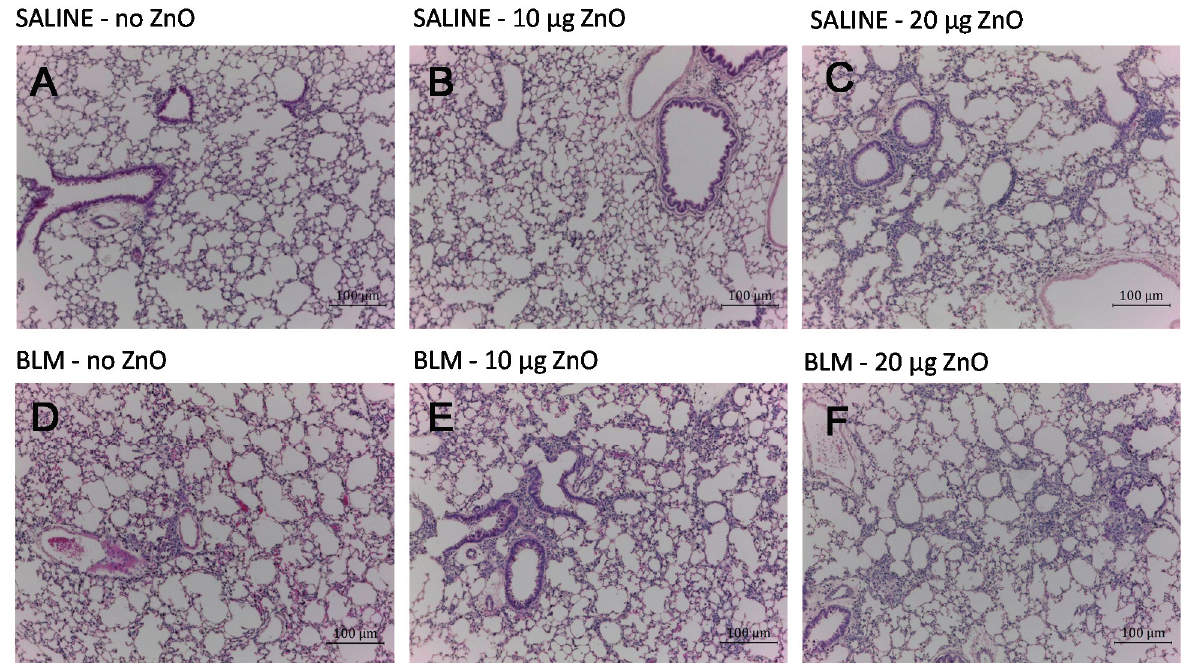
Figure 5. Representative optical micrographs of H&E-stained lung tissues. Mice were exposed to: ( A ) no ZnO; ( B ) 10 µg of ZnO; ( C ) 20 µg of ZnO nanoparticles without BLM treatment; ( D ) no ZnO; ( E ) 10 µg of ZnO and ( F ) 20 µg of ZnO nanoparticles with BLM treatment. Samples were collected at Day 14 after administration.